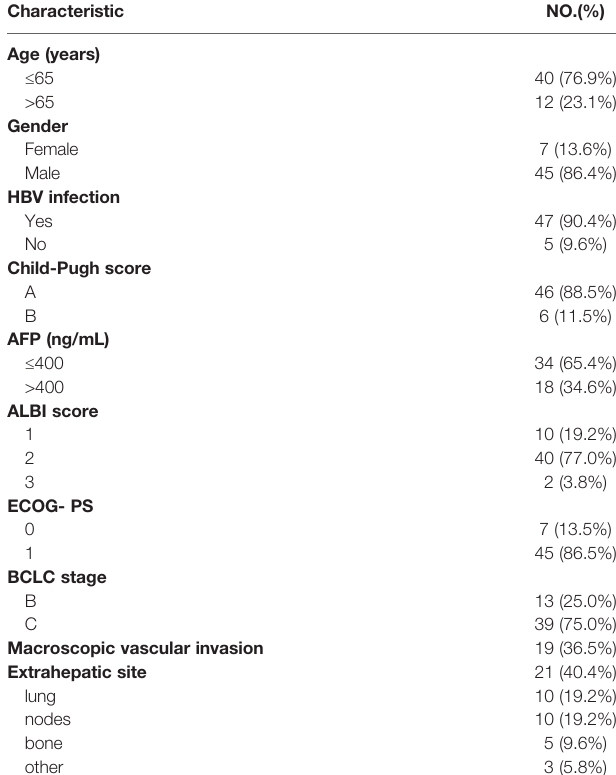
TABLE 1 | Baseline characteristics of the 52